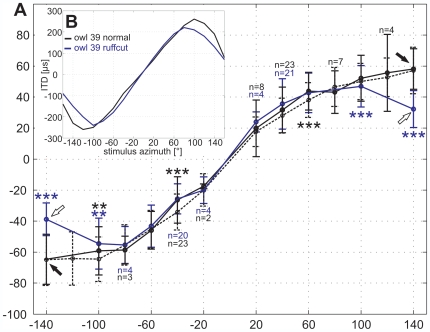
ITDs and azimuthal head-turn angle.(A) The azimuthal head-turn angles were pooled for stimulation with individualized HRTFs (dotted, owls H and S), responses to owl 39 normal (black, all three owls) and to owl 39 ruffcut (blue, all three owls). Stepsize was 20°. Arrows mark ±140° stimulus position, where the azimuthal head-turn angle decreased highly significantly (Mann-Whitney test, p<0.0001) in the ruffcut condition. Note that, in contrast to the ruffcut condition, the head-turn angles with intact ruff (individualized and owl 39 normal) approach a plateau at about ±60°. Significant differences between stimulus conditions are marked with asterisks depending on the significance level (**p<0.01, ***p<0.001) in black (individualized versus owl 39 normal) respectively in blue (owl 39 normal versus owl 39 ruffcut). Each data point includes at least 96 trials, unless indicated otherwise by the number of trials (n). (B) The ITD in µs contained in the HRTFs at 0° elevation is plotted against stimulus azimuth in degree for owl 39 normal (black) and owl 39 ruffcut (blue). Note the sinusoidal course of the ITD. The ITD decreased at peripheral azimuths for both intact as well as for removed ruff. The ITD range was smaller in the ruffcut condition.